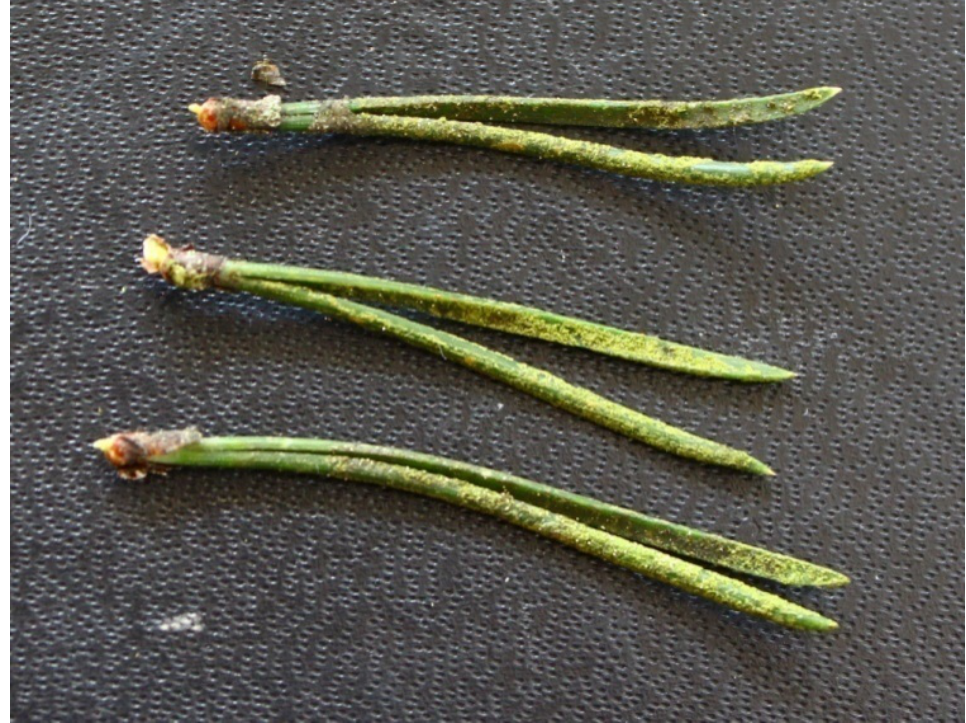
Figure A3. Bog pine needles covered with algae and fungi collected in the ‘Hinterzartener Moor’ in April